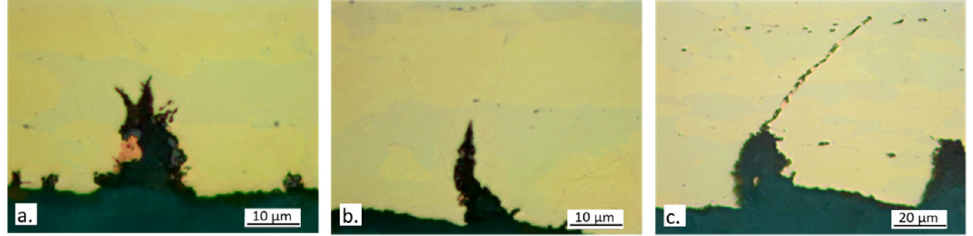
Figure 19. Optical micrographs of sections of CW724R specimens after SSRT in SDW solutions containing ( a ) 100 ppm; ( b ) 400 ppm; and ( c ) 700 ppm chlorides.